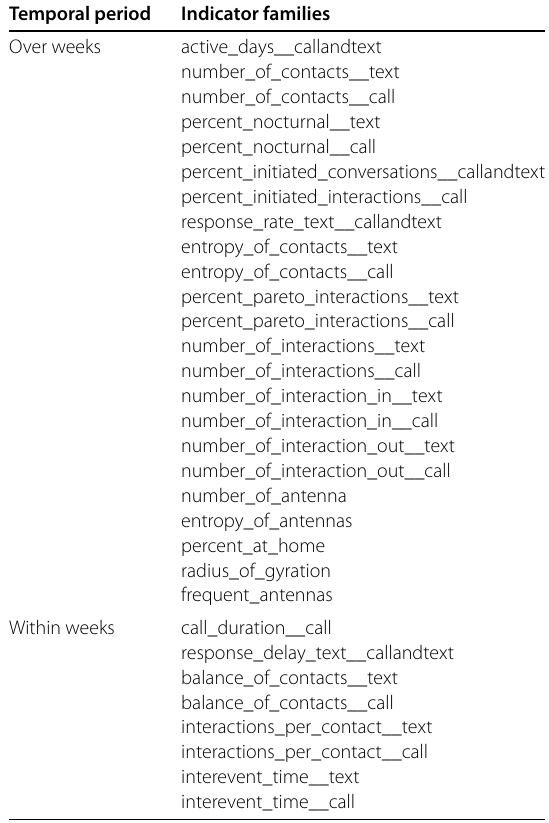
Table 1 All 31 indicator families computed by Bandicoot divided by the temporal unit of the distribution they